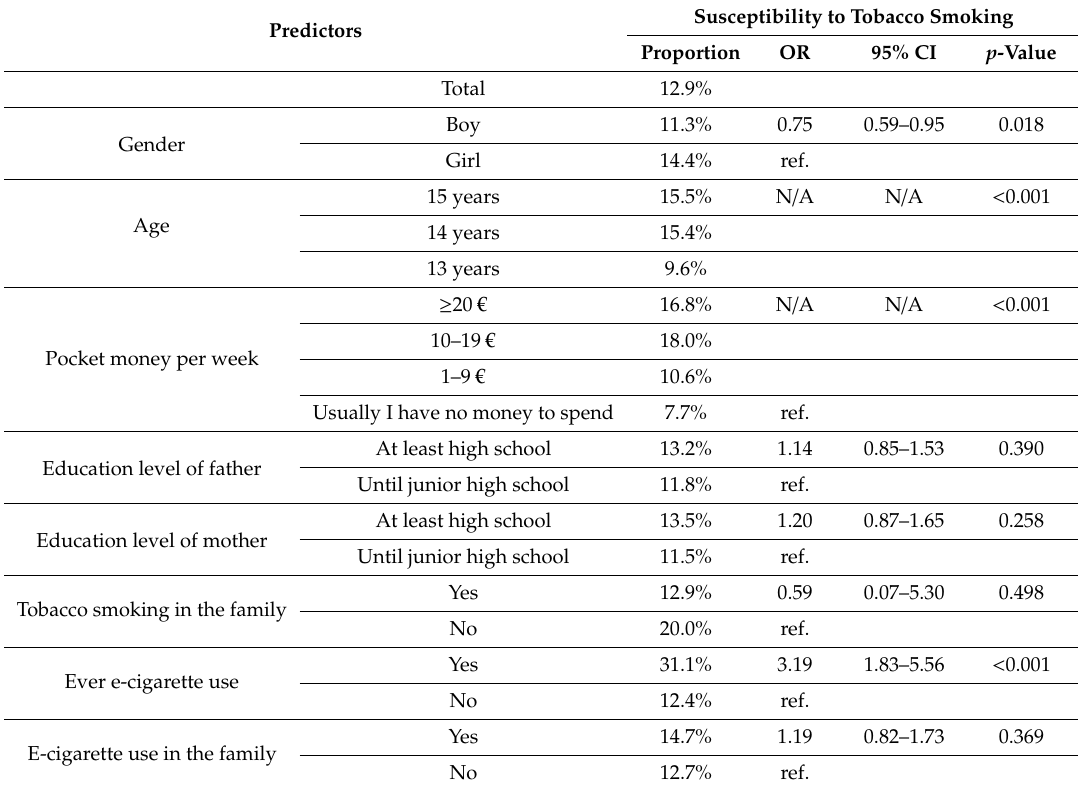
Table 5. Bivariate analysis of susceptibility to tobacco smoking among never smokers.